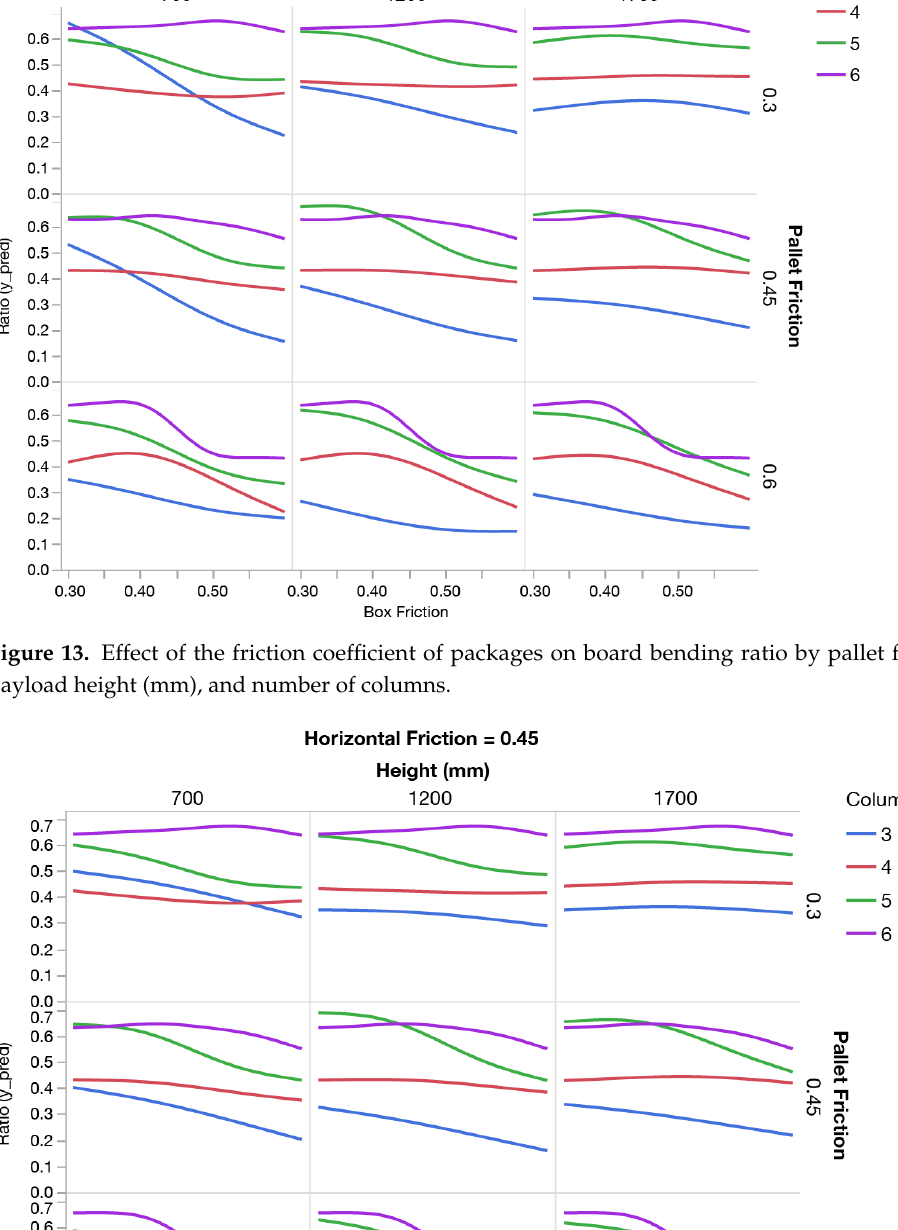
Figure 15. Effect of the friction coefficient of the horizontal surface of the packages on board bending ratio by pallet friction, payload height (mm), and number of columns, with a fixed coefficient of friction of the vertical surface of 0.45.